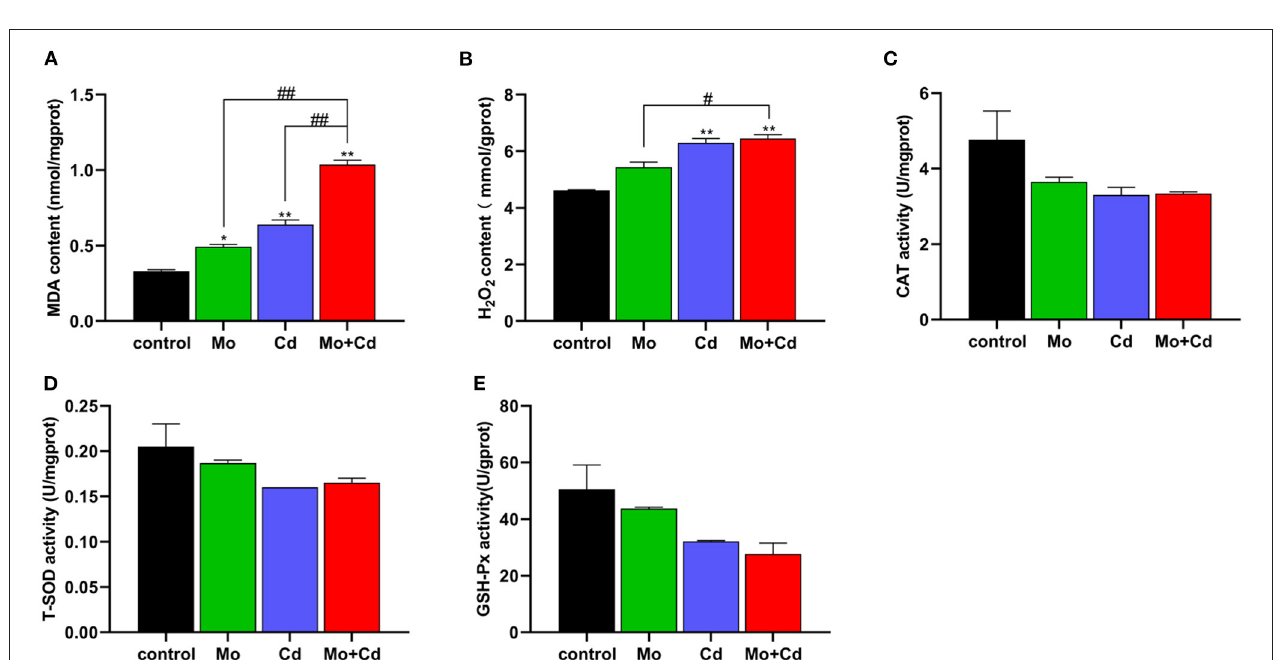
FIGURE 1 | Effects of Mo and/or Cd on trace elements and histopathology in the kidney. (A) Mo content, (B) Cd content (C) Cu content (D) Zn content. (E) Histological characteristics of the kidney. The histopathological lesions included the vacuolar degeneration (red arrows) and granular degeneration (black arrows) in the renal tubular epitheliums. HE staining, scale bar = 50 µ m. Data are expressed as means ± SD ( n = 6). “*” indicates significant difference compared to the corresponding control (* P < 0.05, ** P < 0.01). “#” indicates statistically significant difference between corresponding groups ( # P < 0.05, ## P < 0.01).